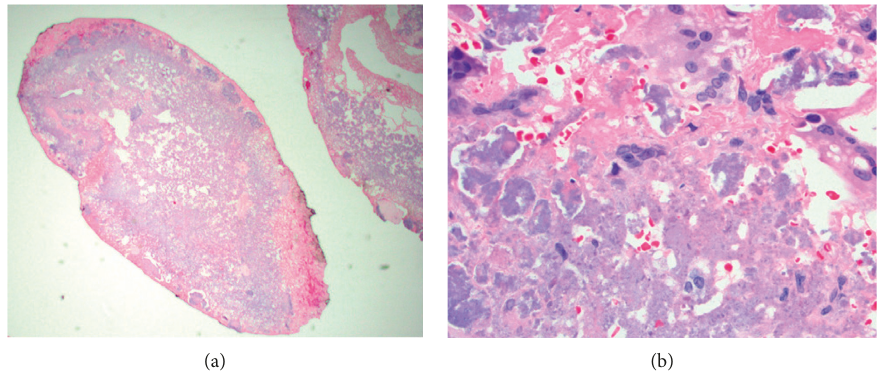
Figure 5: Pathology specimens showing a nodule of amorphous debris and fibrinous material in low-power field (a) and histiocytes and multinucleated giant cells in high-power field (b).